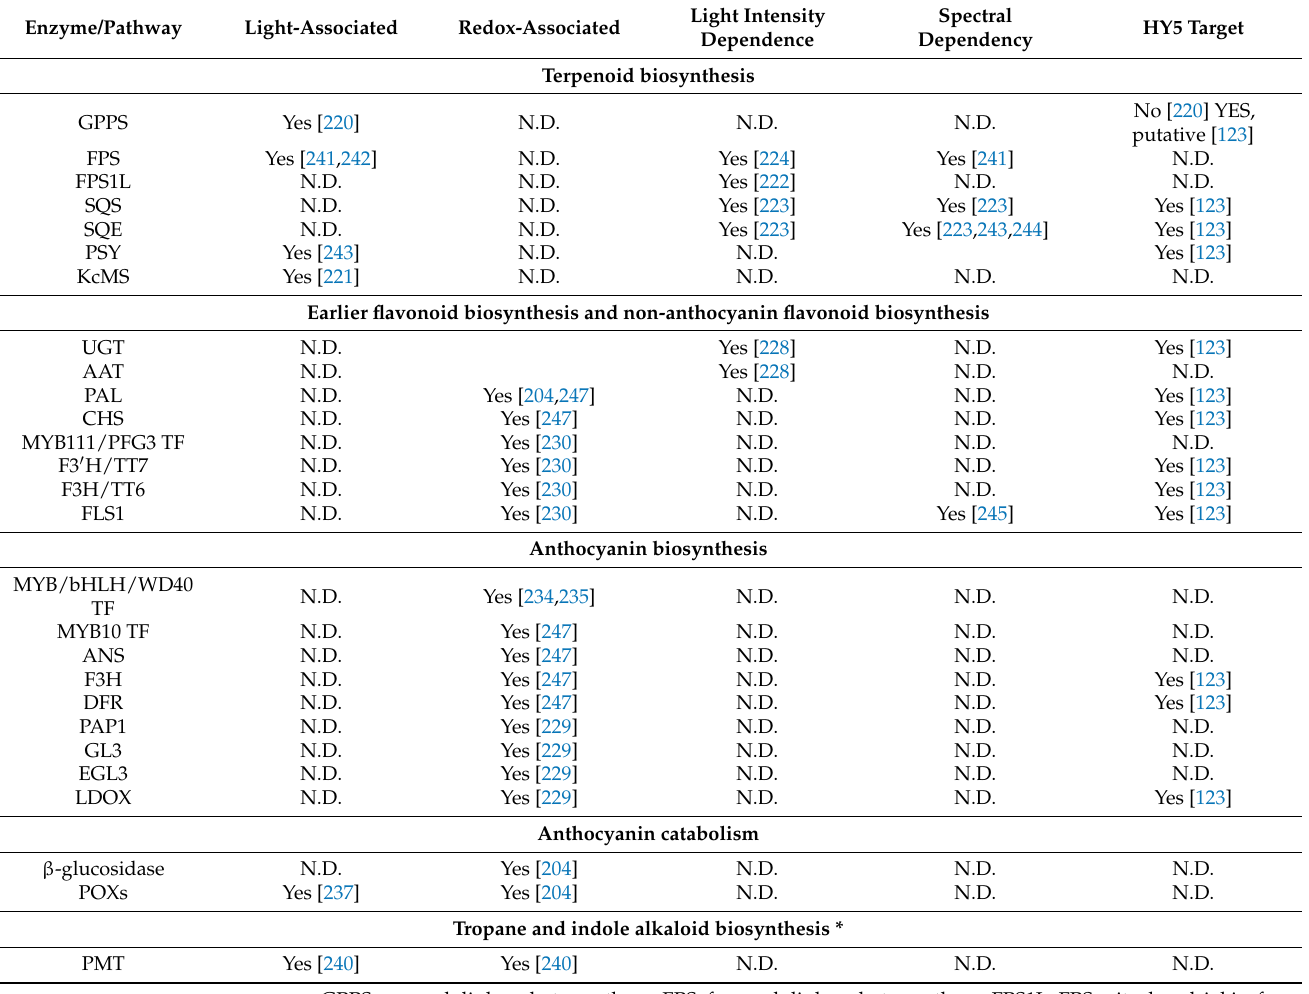
Table A4. Light and/or redox associated regulation of certain proteins (or genes) involved in secondary